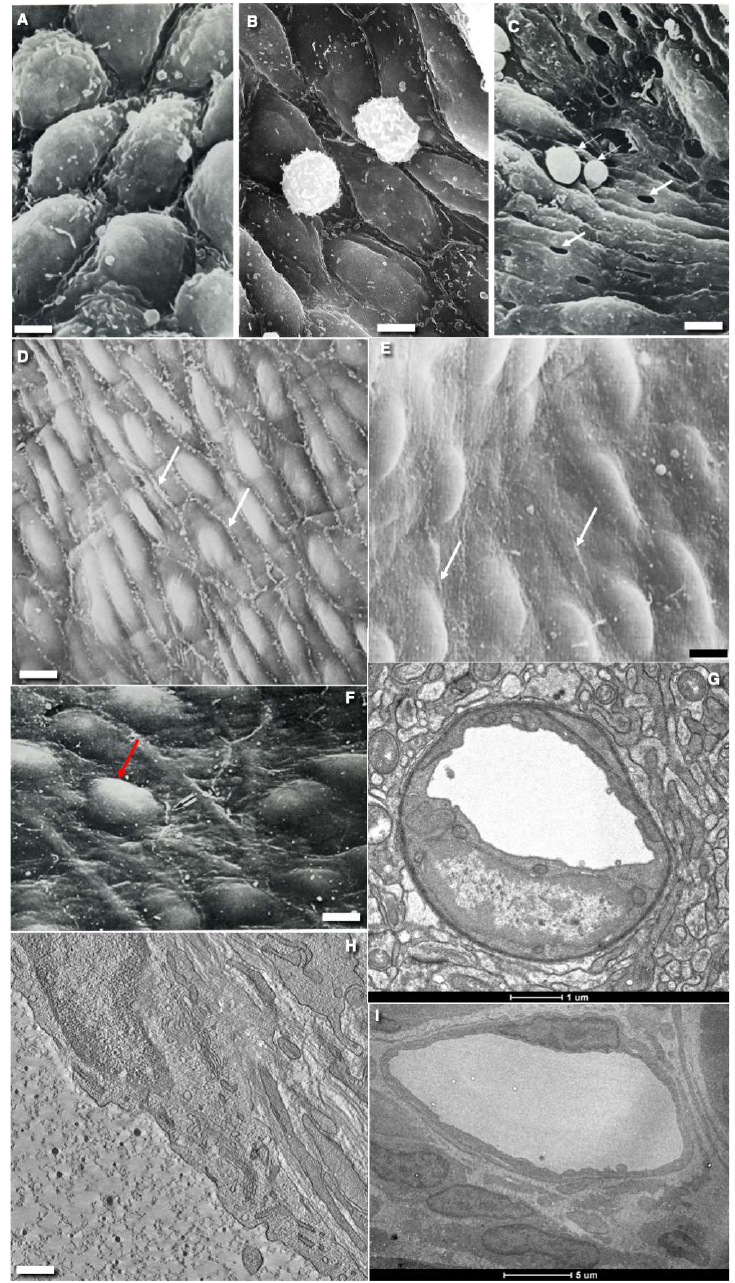
Figure 1. Structure of different types of endothelial cell from rats and mice. ( A , B ) Scanning electron microscopic images of the luminal surface of ECs from the high endothelial venule in lymphatic node. ( C ) SEM of the luminal surface of the endothelium with open contact in rat spleen. White arrows show erythrocytes. ( D ) Scanning electron microscopic image of the luminal surface of rat aorta after perfusion fixation. Cytoplasmic outgrowth (white arrows) are visible along the EC contacts. ( E ) Scanning electron microscopic image of the surface of EGs of the lymphatic thoracic duct. White arrows show near-contact protrusions. ( F ) Scanning electron microscopic image of the luminal surface of vena cava inferior. Black arrow shows rare outgrowths along intercellular contacts. Protrusions/elevation of nuclei of EC are shown with red arrows. Outgrowths along cell contacts are almost invisible. ( G ) Cross section of the brain blood capillary. ECs contain low number of caveolae. ( H ) The virtual EM tomo-slice of cross section of central zone of EC from lymphatic capillary of small intestine villus after starvation. The PM of ECs have only a few caveolae. ( I ) The ECs of